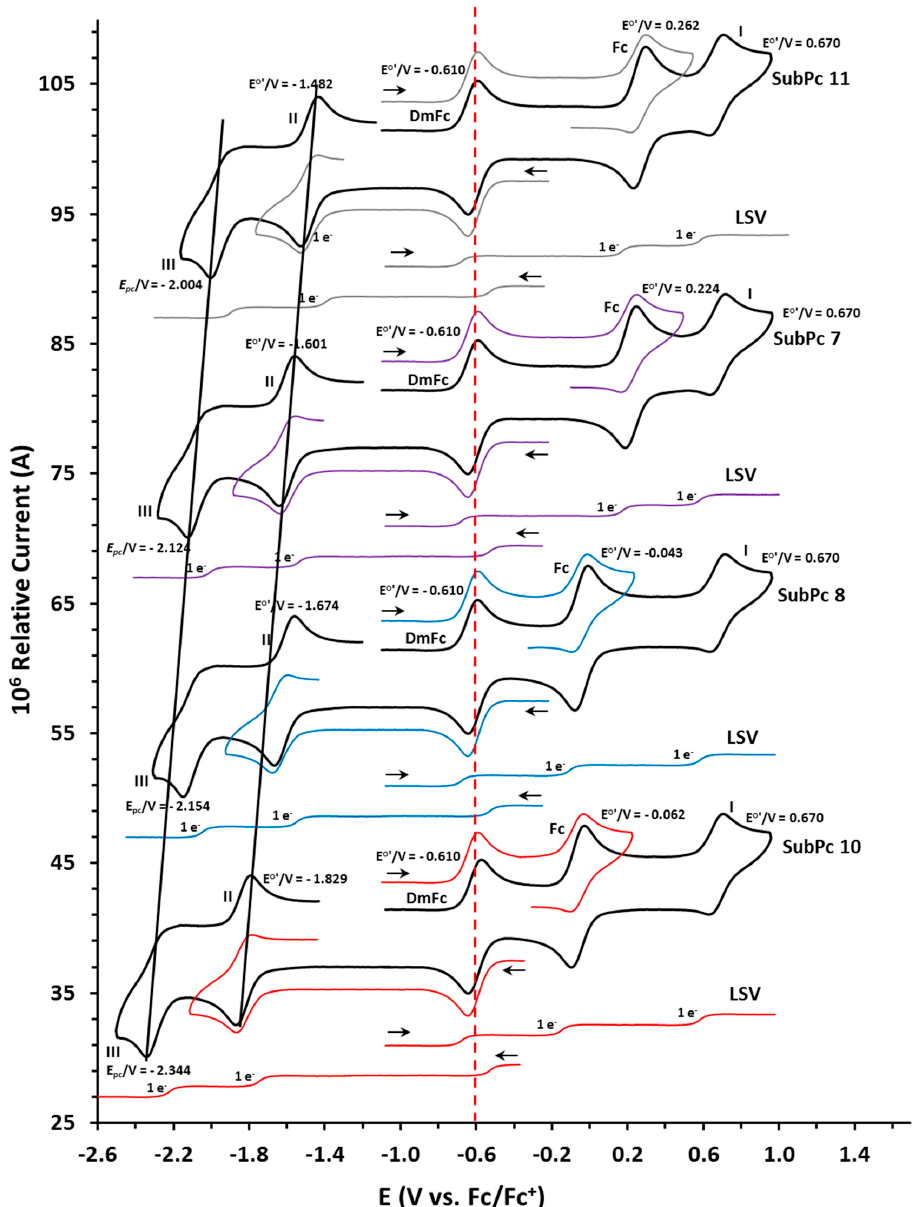
Figure 3. Cyclic voltammetry (CVs) and linear sweep voltammetry (LSVs) of SubPc, 7 —(purple), 8 —(blue), 10 —(red) and 11 —(grey) in dichloromethane (DCM). Concentration of 7, 8, 10 and 11 = 0.0005 mol dm − 3 . Scan rate for CVs is 0.100 V s − 1 and LSVs at 0.001 V s − 1 . Scan directions are indicated at starting point of each scan. DmFc was used as internal reference with E ◦ ’ (DmFc) = − 0.610 vs. free Fc / Fc + at 0 V.